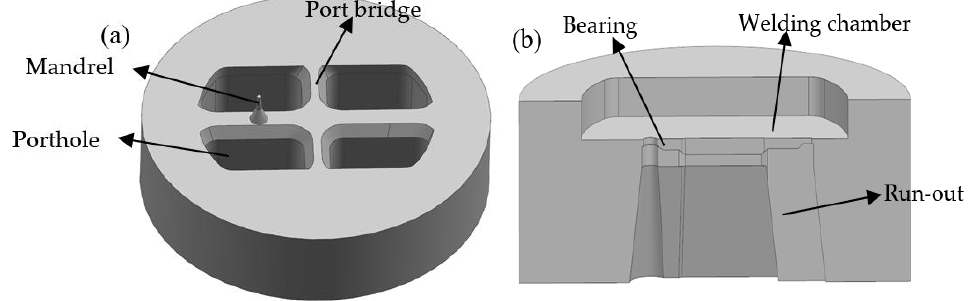
Figure 2. 3D models of the traditional designed die with the welding chamber designed in lower die: ( a ) the upper die and ( b ) the lower die.